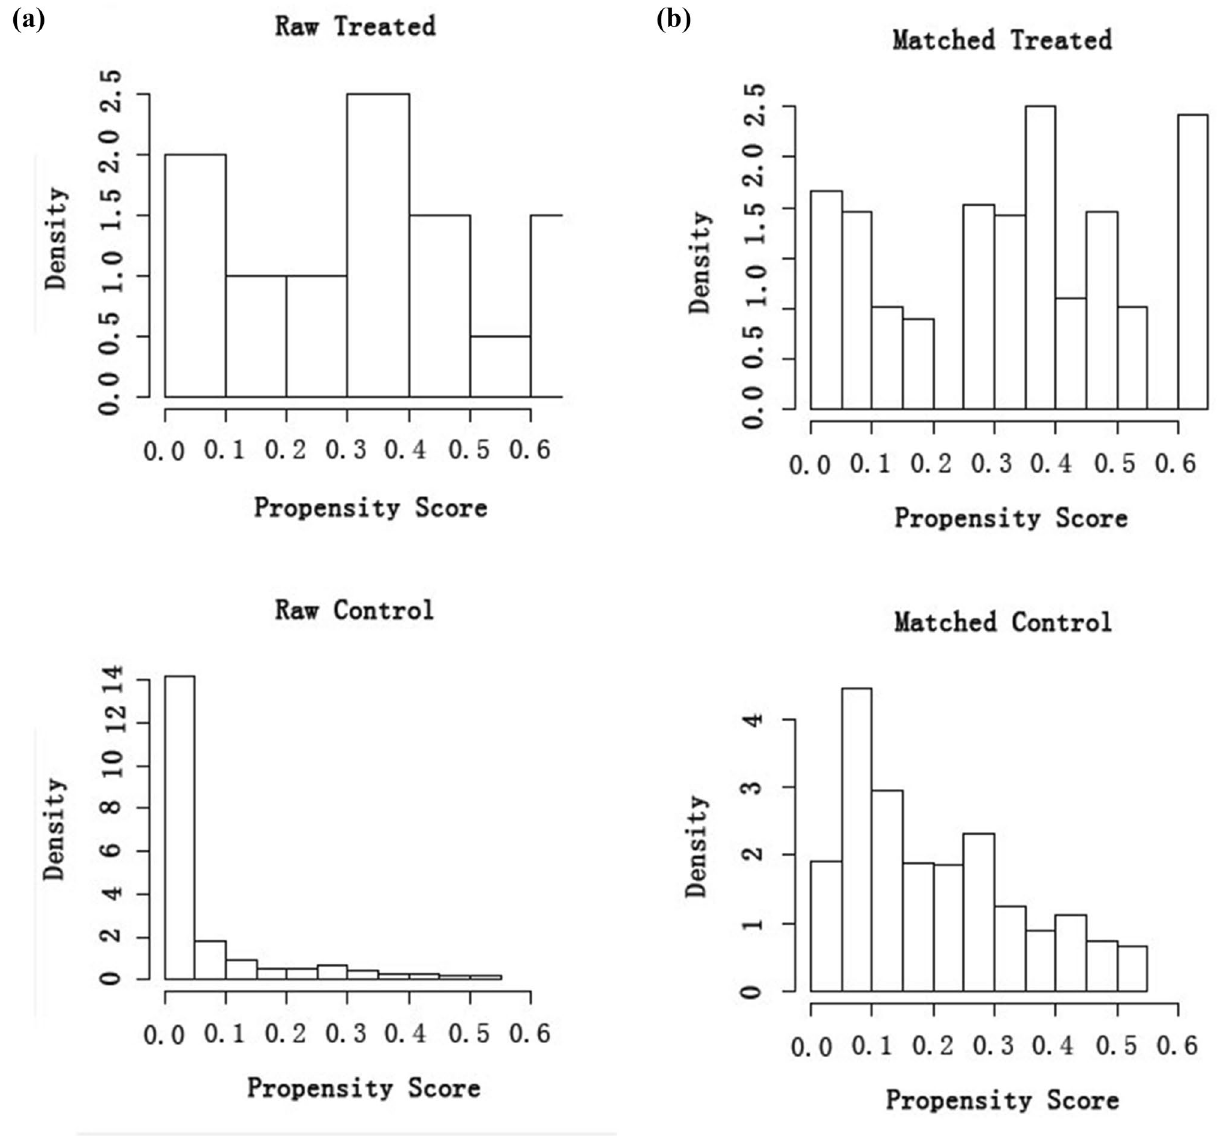
Figure 1. Histograms of the propensity score distribution. ( a ) Histograms of the unmatched participants. ( b ) Histograms of the matched participants. Note: The histograms were created via R package “Matching”. Note: The overall balance of the thirteen variables in the model indicates that the matching process was successful .